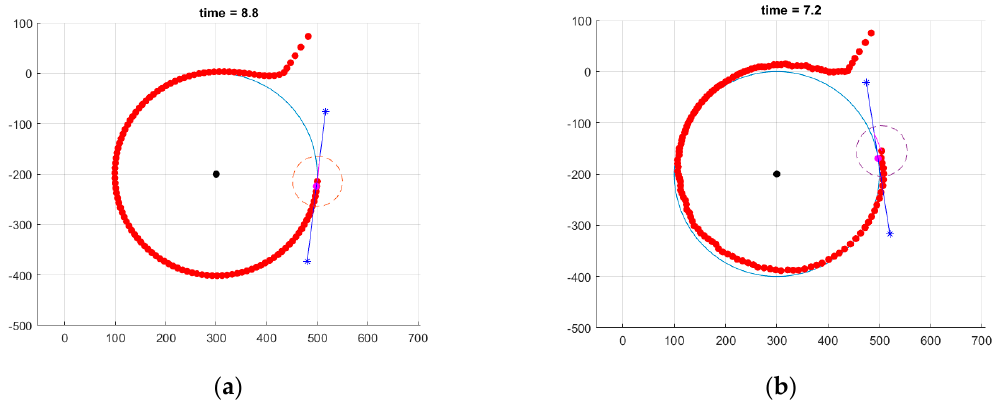
Figure 9. Illustration of loiter circle tracking: ( a ) nominal case and ( b ) with wind disturbances.